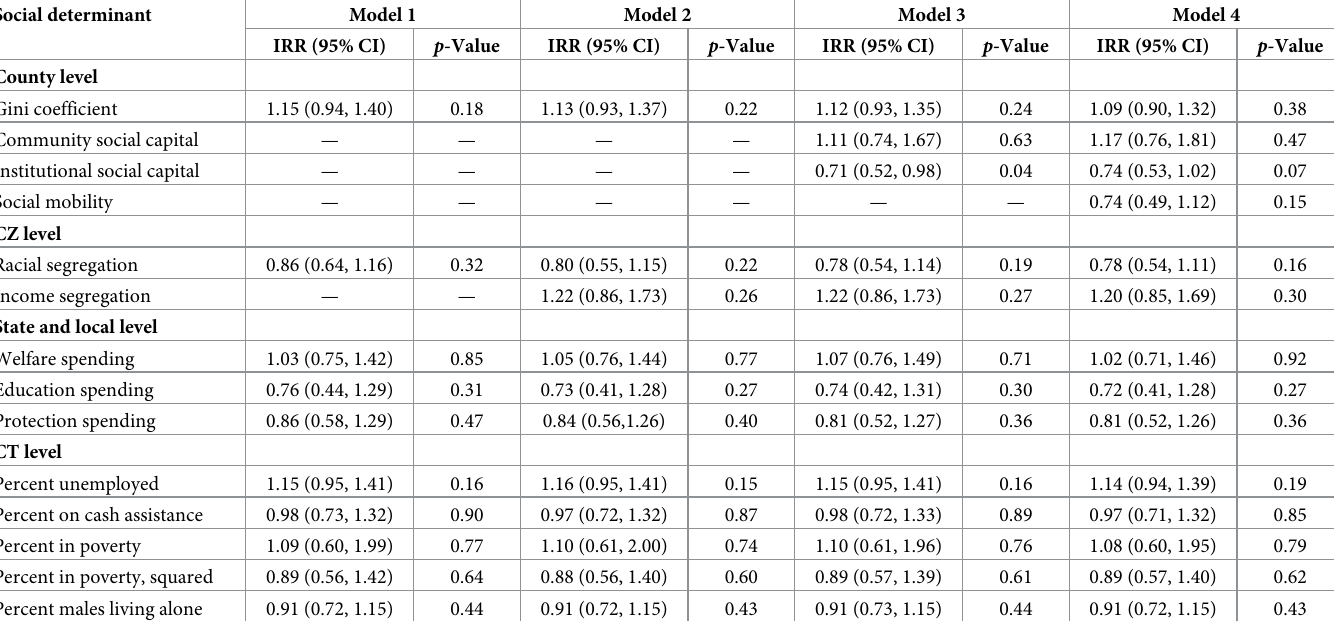
Table 4. Social determinants and the total number of mass shooting homicide incidents at the CT level in the contiguous US,